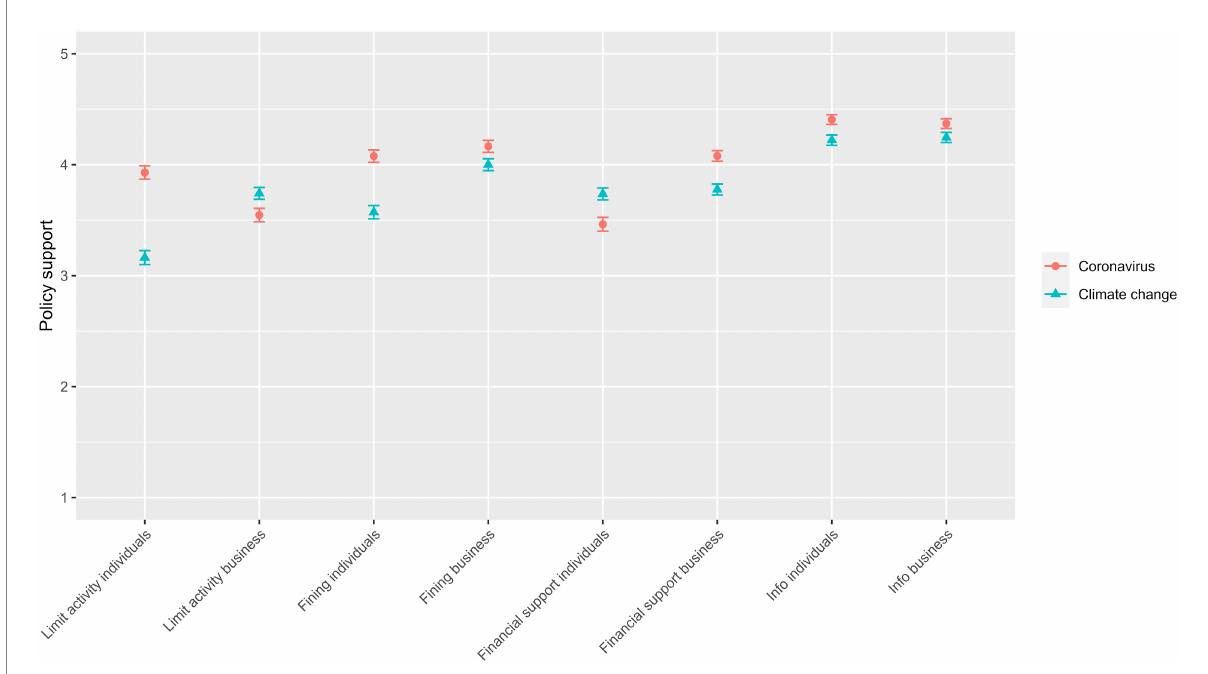
FIGURE 3 Support for different types of policies to address coronavirus and climate